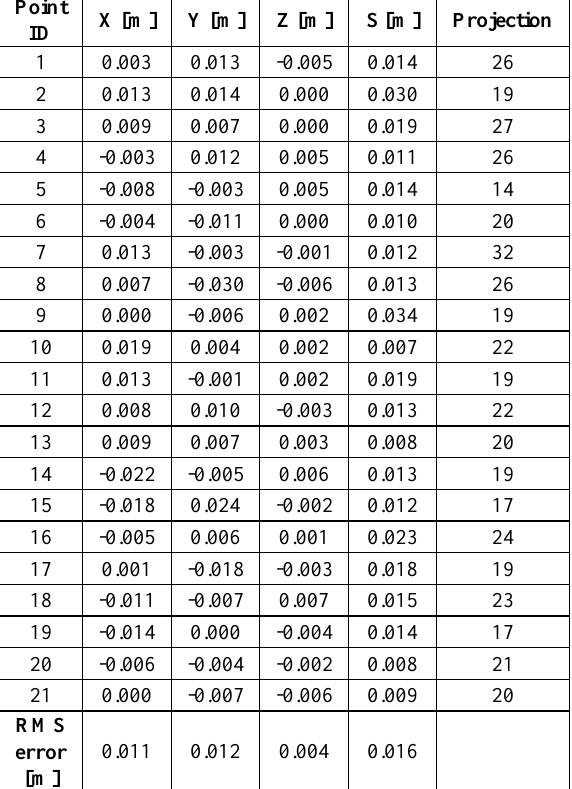
Figure 1. A digital façade model graduated in height